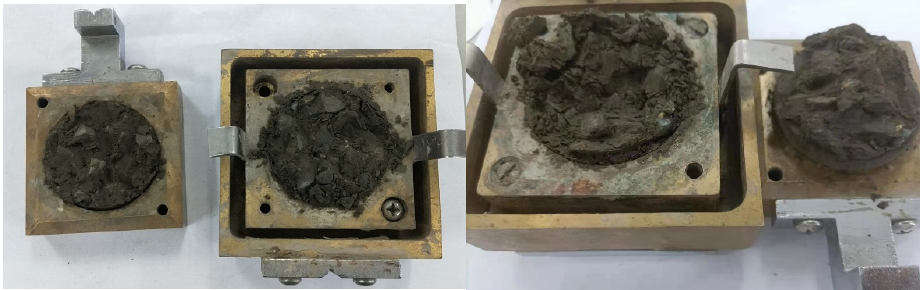
Figure 5. Direct shear failure modes of the samples.